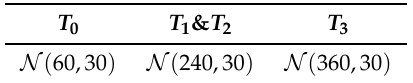
Table 1. Patrolling time for each target in seconds. Normal distributions are characterized by their mean (first parameter) and the standard deviation (second